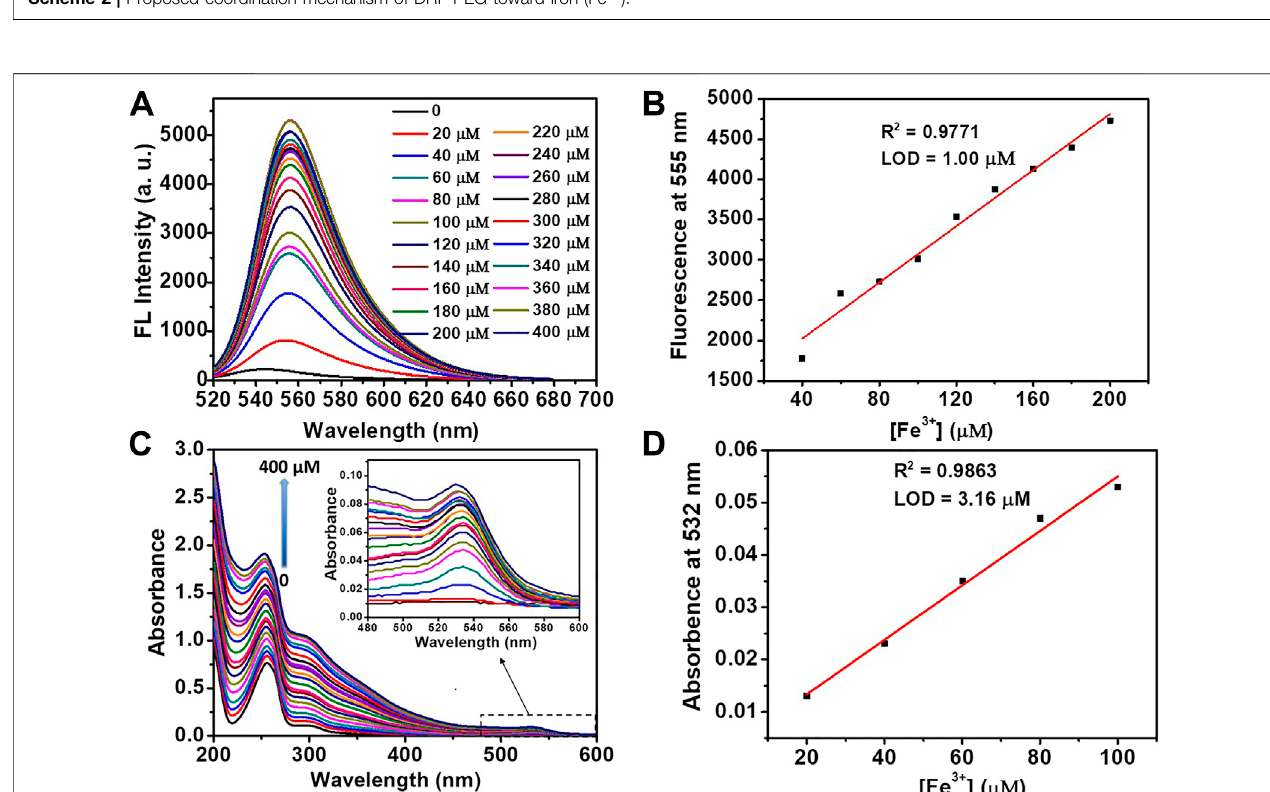
FIGURE4| Fluorescence (A) andabsorption (C) titration ofDRF-PEG(0.1 mg/ml)withtheadditionofvarious concentrationsofFe 3+ (0 – 400 μ M)inwater(pH 6.5). Plot of fl uorescent emission intensity at 555 nm (B) and UV-Vis absorption intensity at 532 nm (D) as a function of [Fe 3+ ].